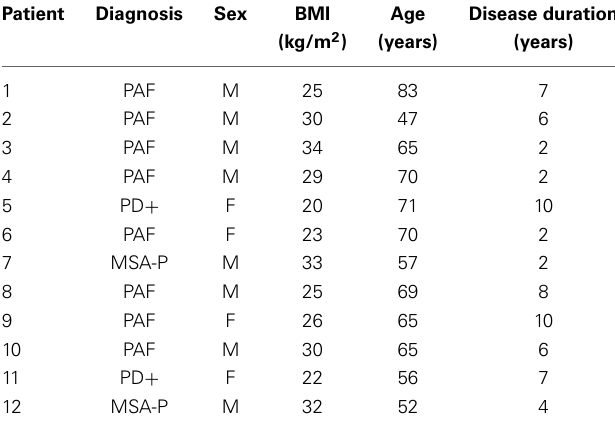
Table 1 | Patient clinical characteristics.